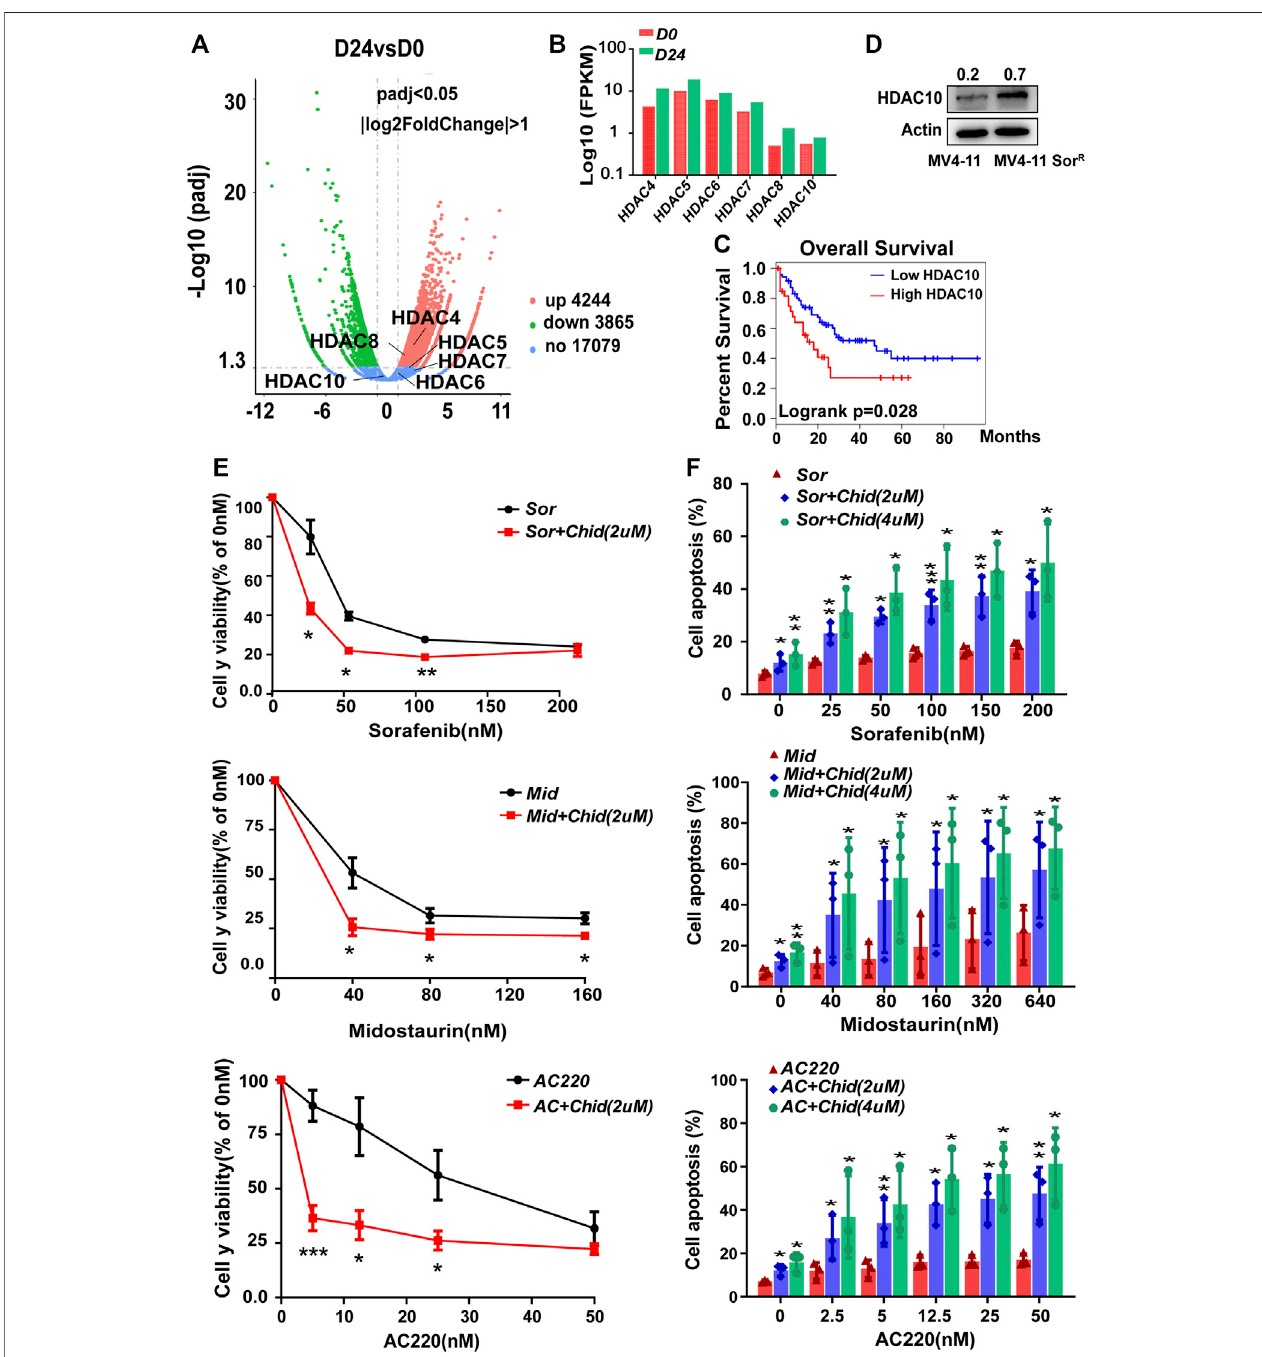
FIGURE4| HDAC10contributedtotheresistanceofFLT3-ITD + AMLcells,andselectiveHDAC10inhibitorchidamidesynergisticallyenhancedthecytotoxiceffect of FLT3 inhibitors. (A) Volcano plot showed both positively (red) and negatively (green) selected genes by the RNA sequence at 24 d post sorafenib treatment. (B) Validation of selected genes in the Volcano plot using Fpkm assay in RNA sequence. (C) OS analysis of AML patients ( n = 144) using the expression of HDAC10 from TCGA database. (D) Expression level of HDAC10 was analyzed by Western blot in MV4-11 cells and MV4-11-sor R cells. (E) Cell growth inhibition of MV4-11 cells wascalculatedafter48 hoftreatment withserialdilutionsofFLT3inhibitorssorafenib,midostaurin,andAC220 combined withchidamide (2mM). (F) MV4-11 cellswere treatedwithserialdilutionsofsorafenib,midostaurin,andAC220combinedwithchidamide(2uM,4uM)for24 htomeasureapoptosisby fl owcytometry.Dataareshown as mean ± SD of three independent experiments; * p < 0.05; ** p < 0.01; *** p < 0.001.